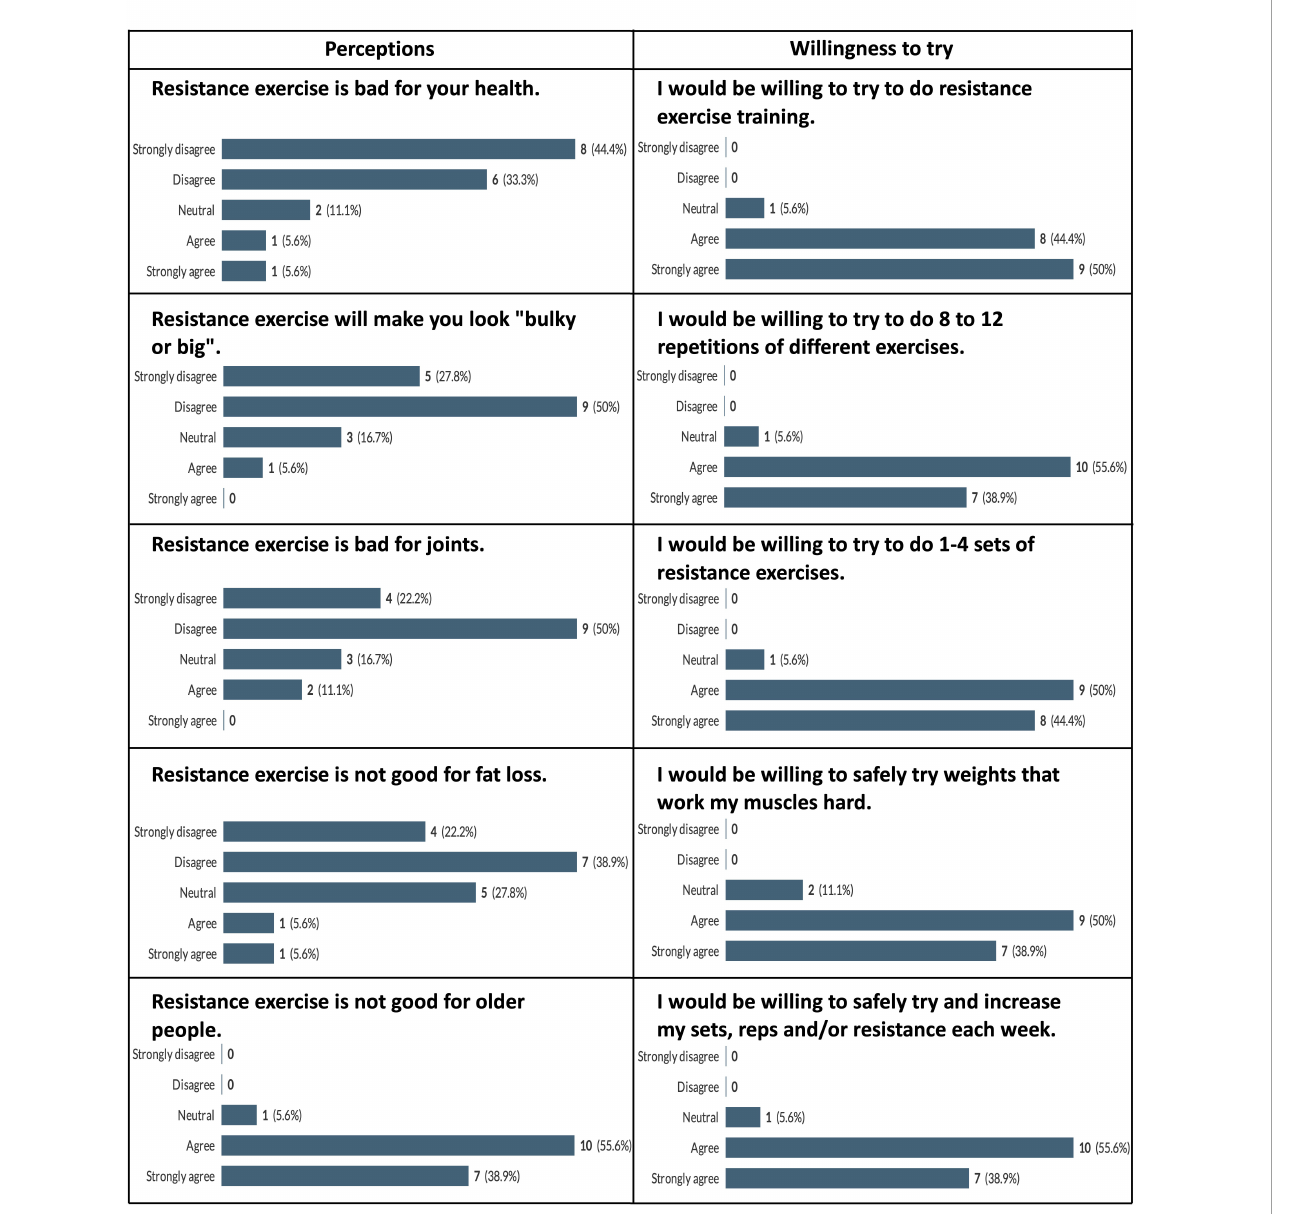
FIGURE6 Pooled participant responses to questions relating to perceptions of and willingness to try resistance exercise. Displayed as number and (percentage) of responses to each answer option (e.g., 100% would represent that all this question’s responses chose that